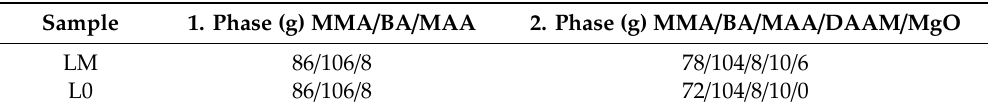
Table 1. The ratio of monomers and nanoparticles of latex